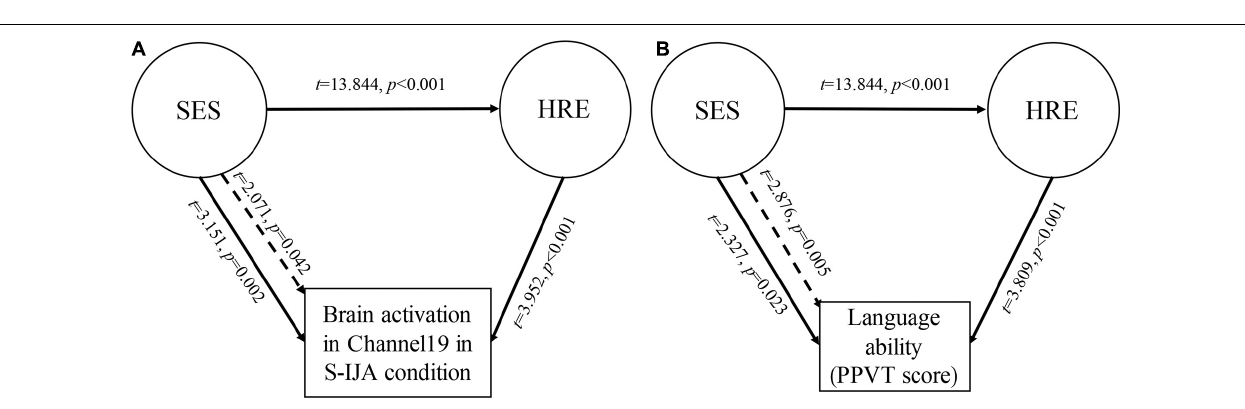
FIGURE 4 | Heatmaps of prefrontal activation difference during the Initiating Joint Attention (IJA) task. (A) Heatmap of prefrontal activation difference between two social interaction conditions (i.e., interaction with stranger and that with teacher) in the IJA task. (B) Heatmap of prefrontal activation differences between Low-SES and Relatively High-SES children. The heatmaps displayed the interpolated F -values, where channels with significant activation differences were highlighted in yellow, and channels with non-significant differences were plotted in blue. L, the left hemisphere of brain; R, the right hemisphere of brain; SES, socioeconomic status.